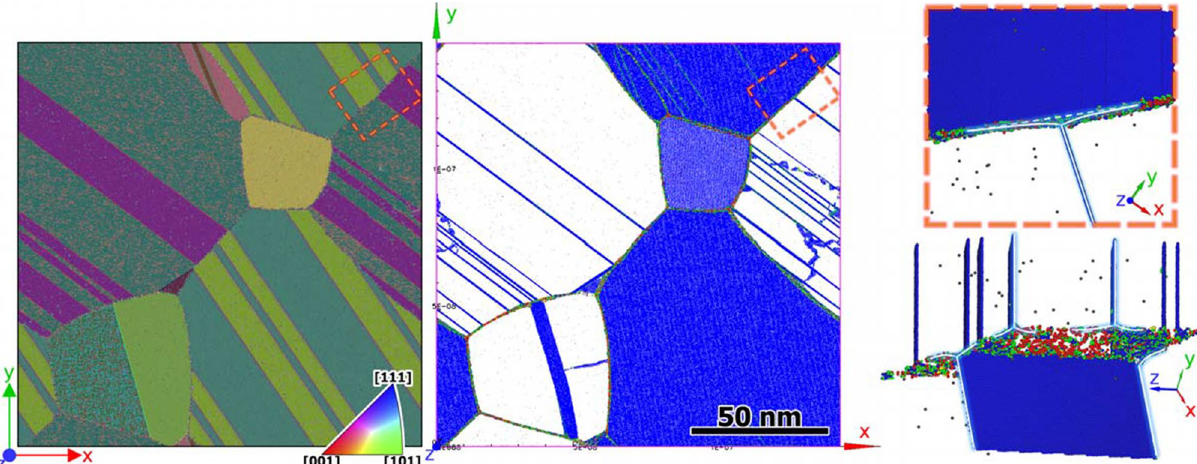
Figure 5. The grain orientation map from PTM analysis (on the left) and the defect structure recognized by the ATA (in the middle) in the M-type sample at t = 35 ns . The enlarged defect structure in the box designated by the dashed rectangles is shown on the right. The blue color is for twin boundary atoms, the green is for atoms with hcp surroundings, the red shows atoms of unrecognized structure. The gray dots are vacancies in the fcc structure. Atoms belonging to the fcc structure are not shown. On the lower right, the same enlarged defect structure as on the upper right is shown tilted to demonstrate twin boundaries in the upper grain seen from the edge.